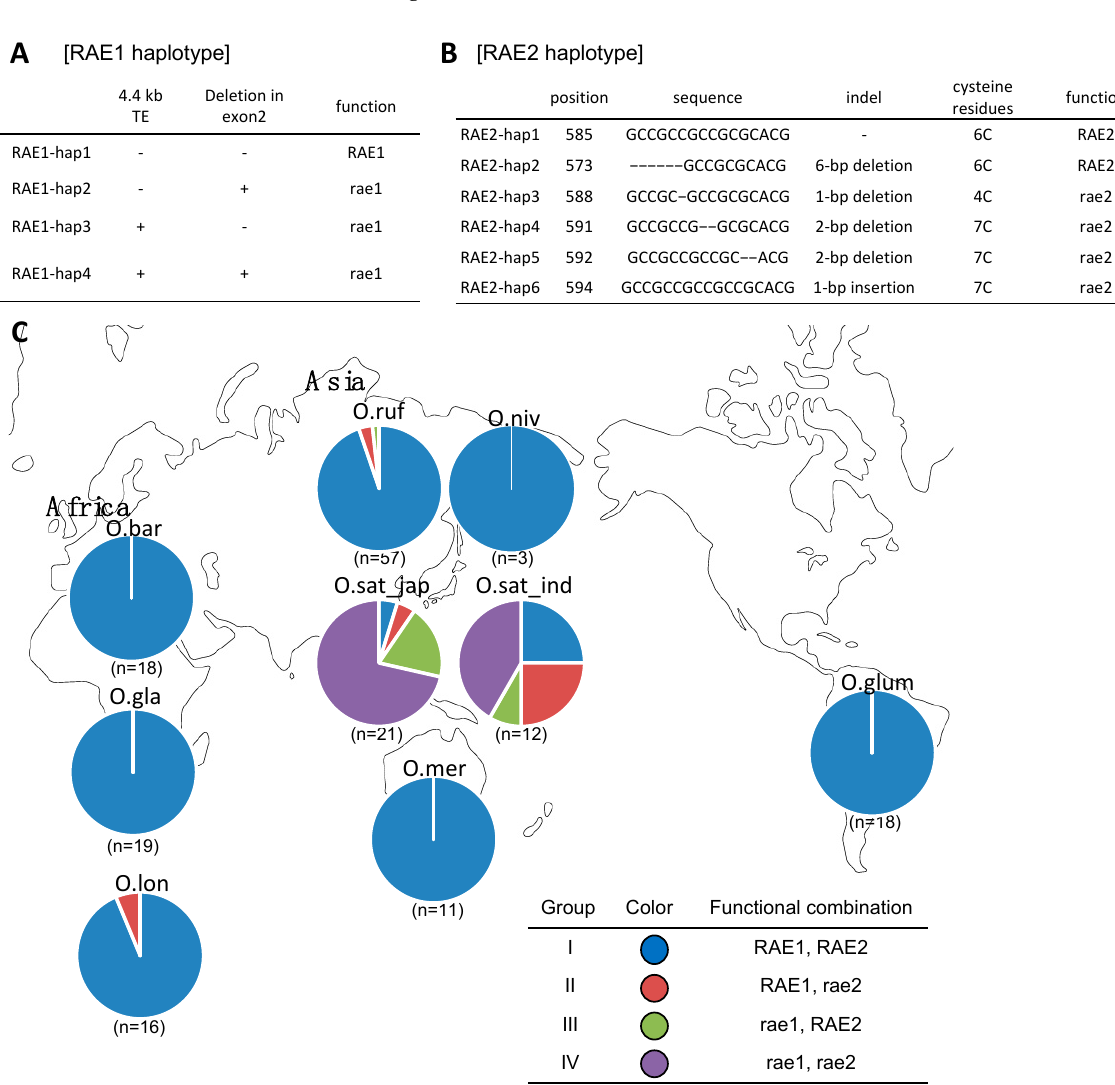
Figure 5. Frequency of the combination of RAE 1 and RAE 2 haplotypes. ( A , B ) Haplotypes in RAE1 ( A ) and RAE2 ( B ) categorized based on the comparison between O. rufipogon and O. sativa ssp. japonica/indica . ( C ) Combinations of the RAE1 and RAE2 haplotypes among the AA genome species were classified into four groups. The pie chart indicates the percentage of each group, where blue, red, green, and purple indicate groups I, II, III, and IV, respectively. Numbers below the pie charts are the numbers of accessions used for this analysis. Green and orange squares indicate cultivated rice species and their wild progenitors in Africa and Asia, respectively. O.bar, O. barthii ; O.gla, O. glaberrima ; O.lon, O. longistaminata ; O.mer, O. meridionalis ; O.glum, O. glumaepatula ; O.ruf, O. rufipogon ; O.niv, O. nivara ; O.sat_jap, O. sativa ssp. japonica ; O.sat_ind, O. sativa ssp. indica